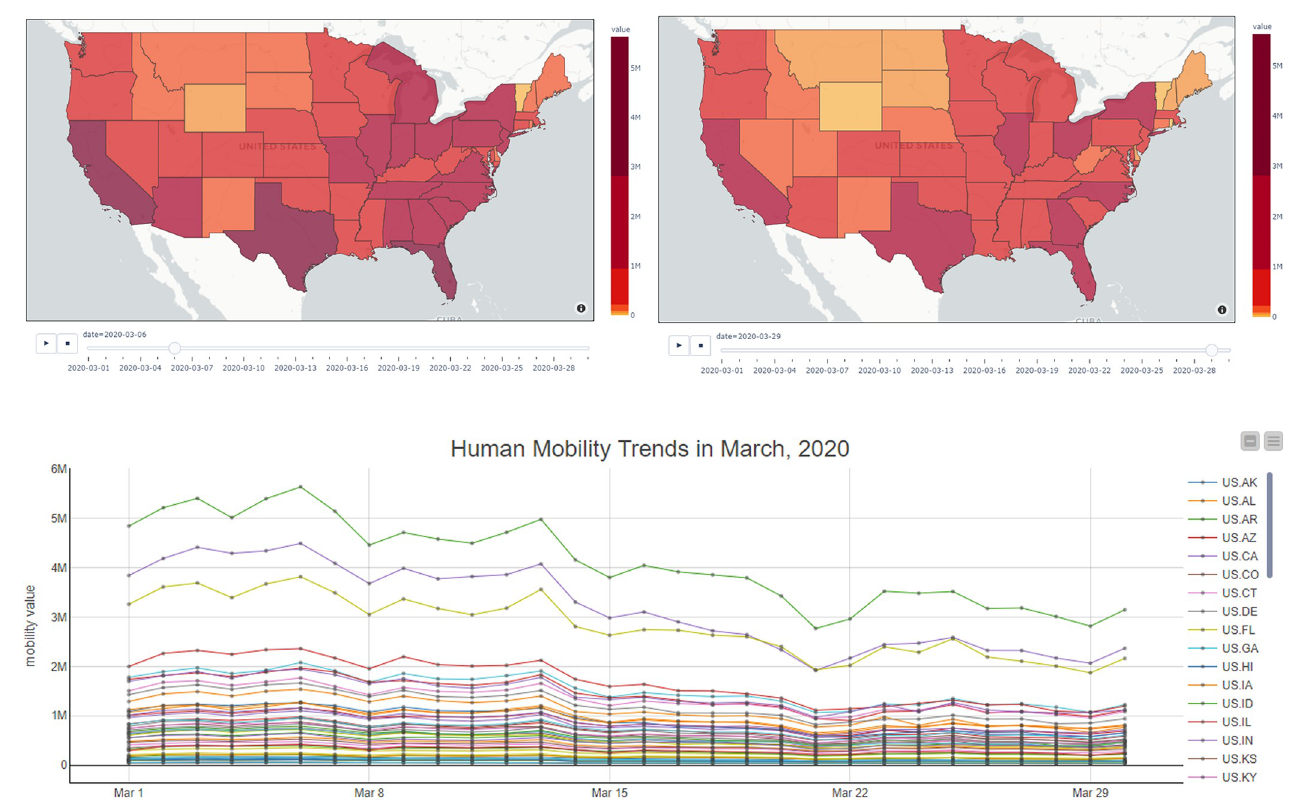
Fig 10. Visualization results of human mobility trends from the